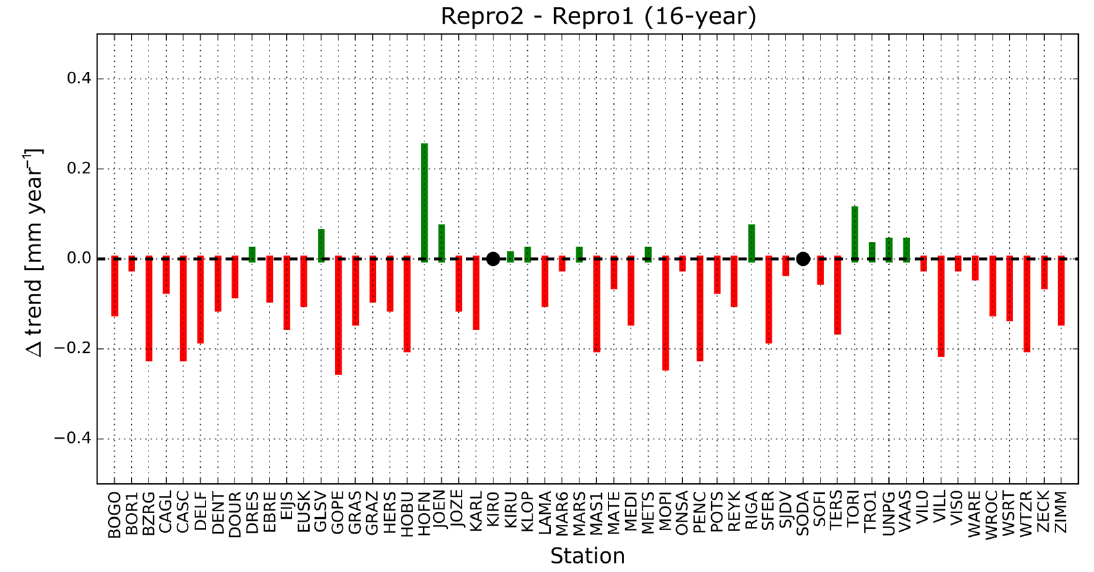
Figure 6. Differences between the values of the 16-year linear trends obtained from the Repro2 and the Repro1 campaigns.